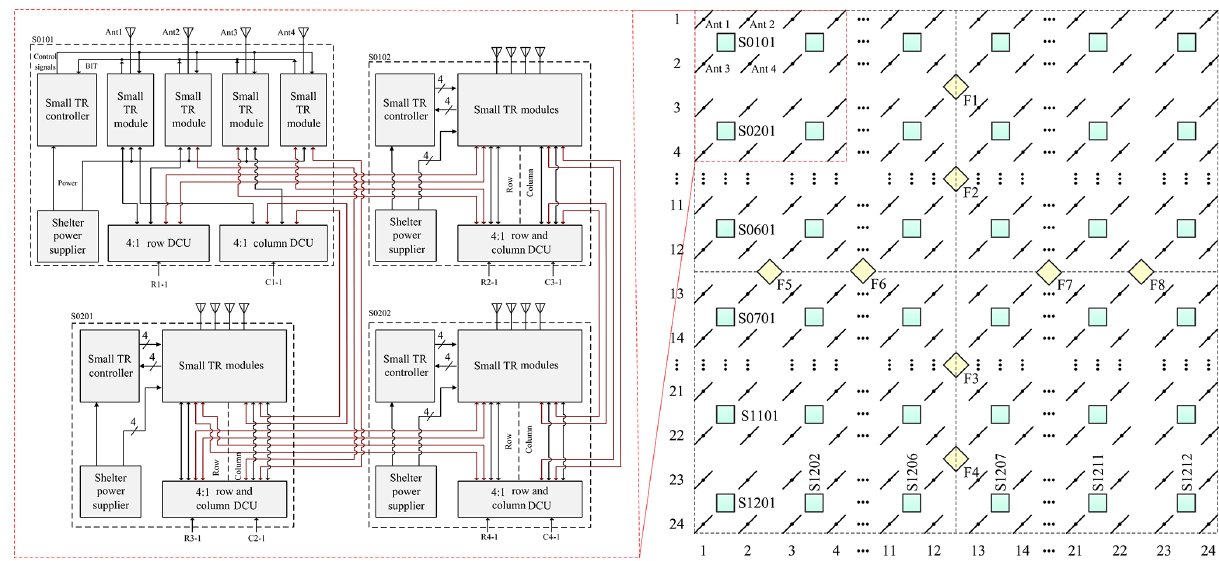
Figure 2. Arrangement of the Wuhan MST radar antenna field and interconnections of four surrounding shelters.